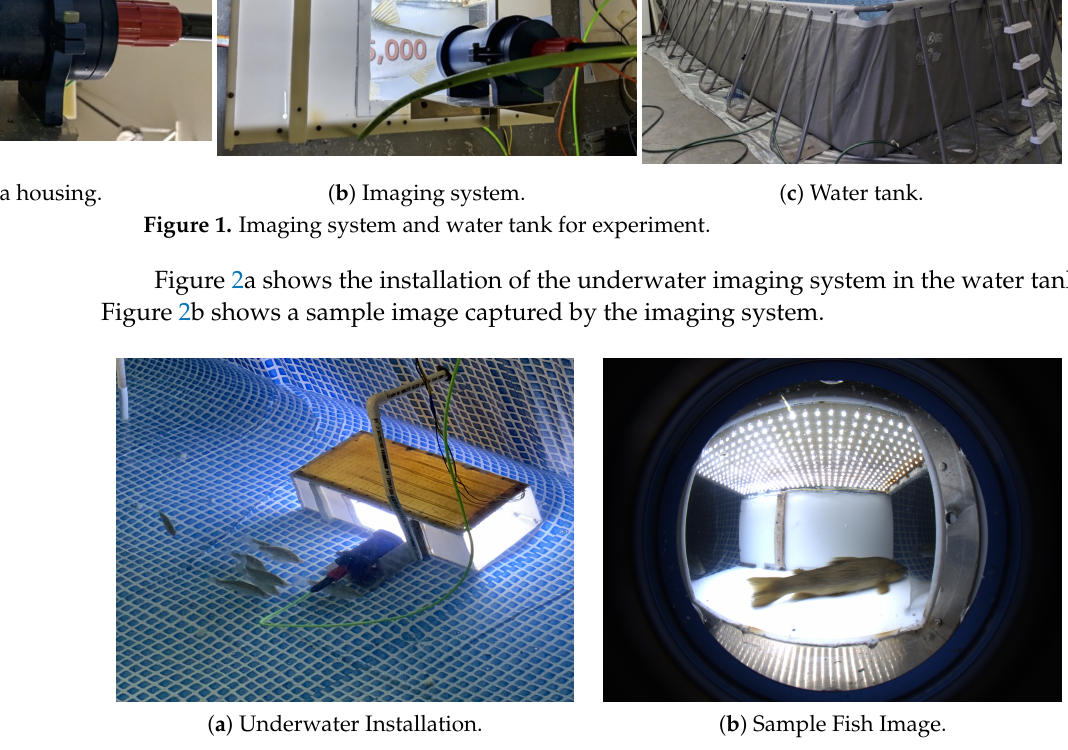
Figure 2. Underwater imaging system installation and sample fish